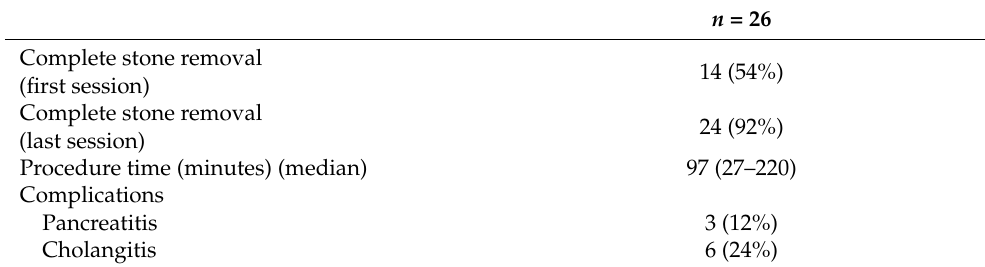
Table 2. Results of endoscopic